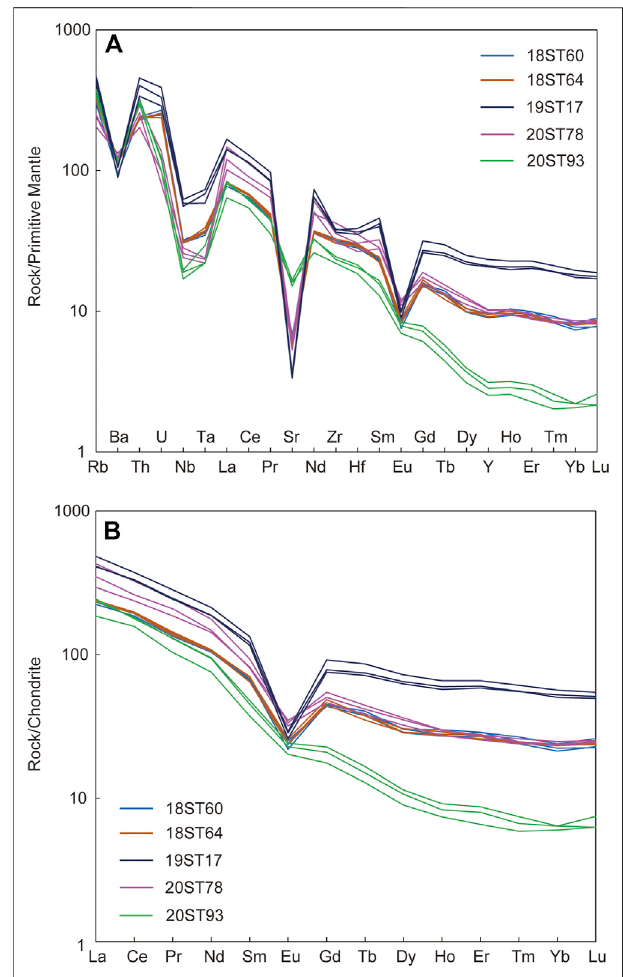
FIGURE 9 | (A) Primitive mantle-normalized multi-element distributions showing the signi fi cant negative Nb and Ta anomalies, and conspicuous enrichments of LILEs such as Rb, Th, U; (B) Chondrite-normalized REE patterns showing the evident enrichments in light rare earth elements (LREEs) relative to heavy rare earth element (HREE), which all point to subduction-related trace element signatures. Chondrite and primitive mantle values are after Sun and McDonough